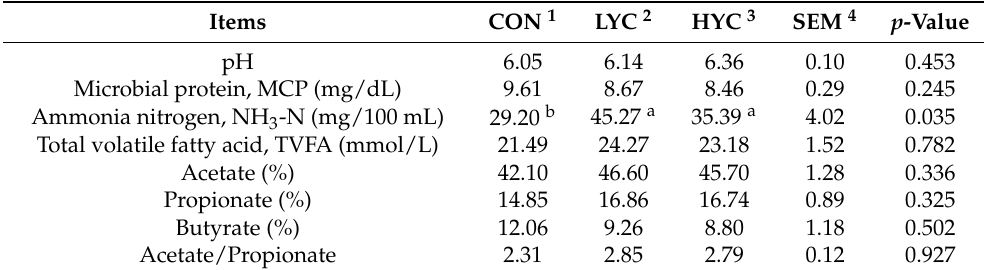
Table 5. Effect of dietary different supplemental levels of YC on the rumen fermentation parameters of fattening Hu sheep.